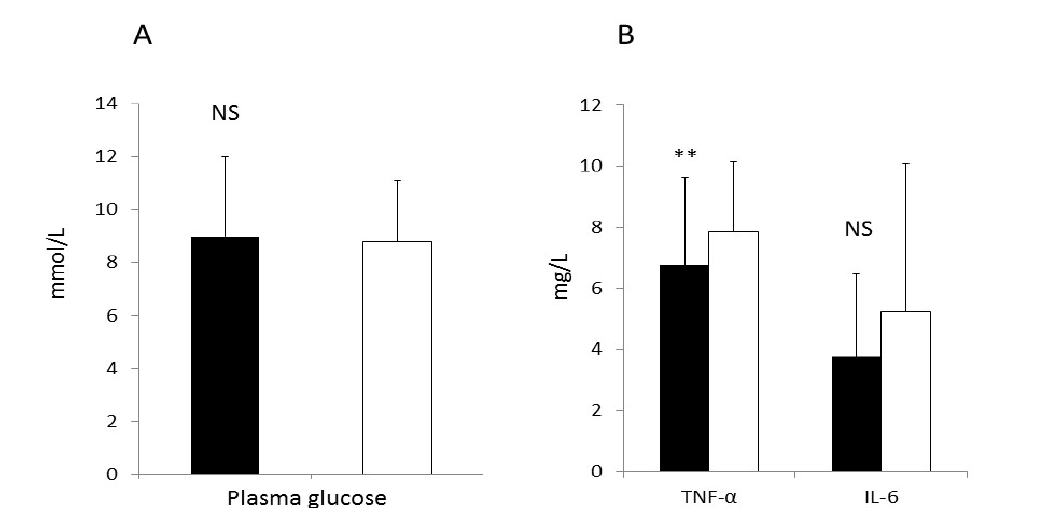
Figure 2. Plasma concentrations of glucose ( A ) and plasma concentrations of interleukin 6 (IL-6) and tumor necrosis factor-α (TNF-α) ( B ) after the egg (dark bar) and the oatmeal (white bar). Mean values for plasma glucose were 9.0 ± 3.0 mmol/L and 8.8 ± 2.3 mmol/L after the oatmeal periods. IL-6 were 3.8 ± 2.7 pg/mL following the egg breakfast ( p = 0.051) and 5.2 ± 4.8 pg/mL after the oatmeal and for TNF-α were 6.7 ± 2.8 pg/mL after the egg breakfast ( p = 0.007) and 7.9 ± 2.7 pg/mL after the oatmeal. *Indicates significantly different p < 0.05 and ** p < 0.01. NS =